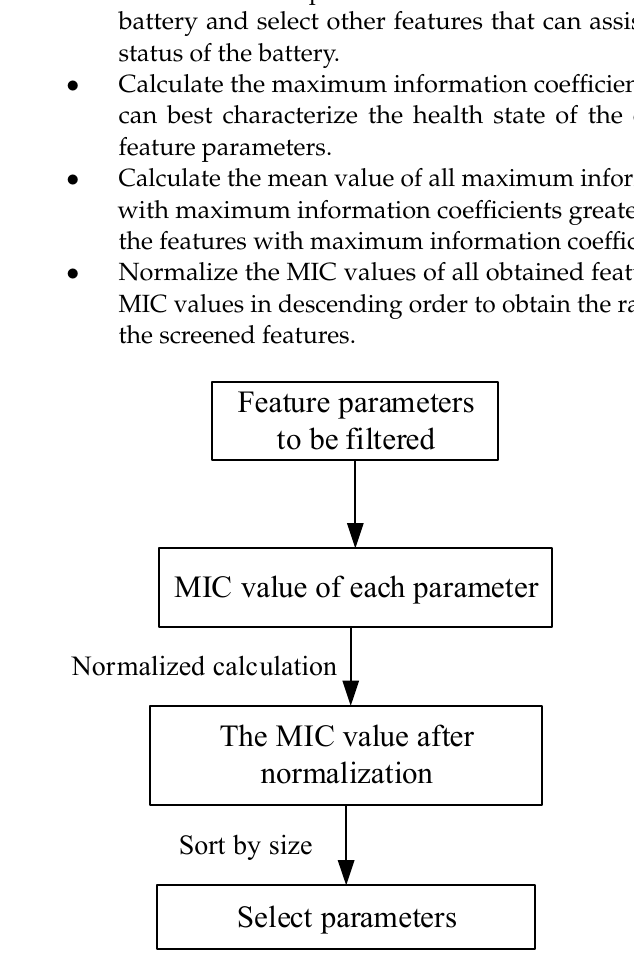
Figure 3. Feature parameter selection process.